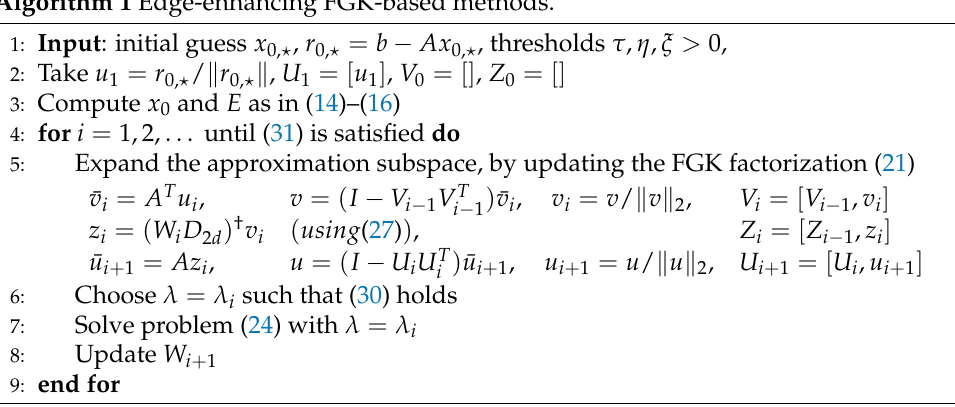
Algorithm 1 Edge-enhancing FGK-based